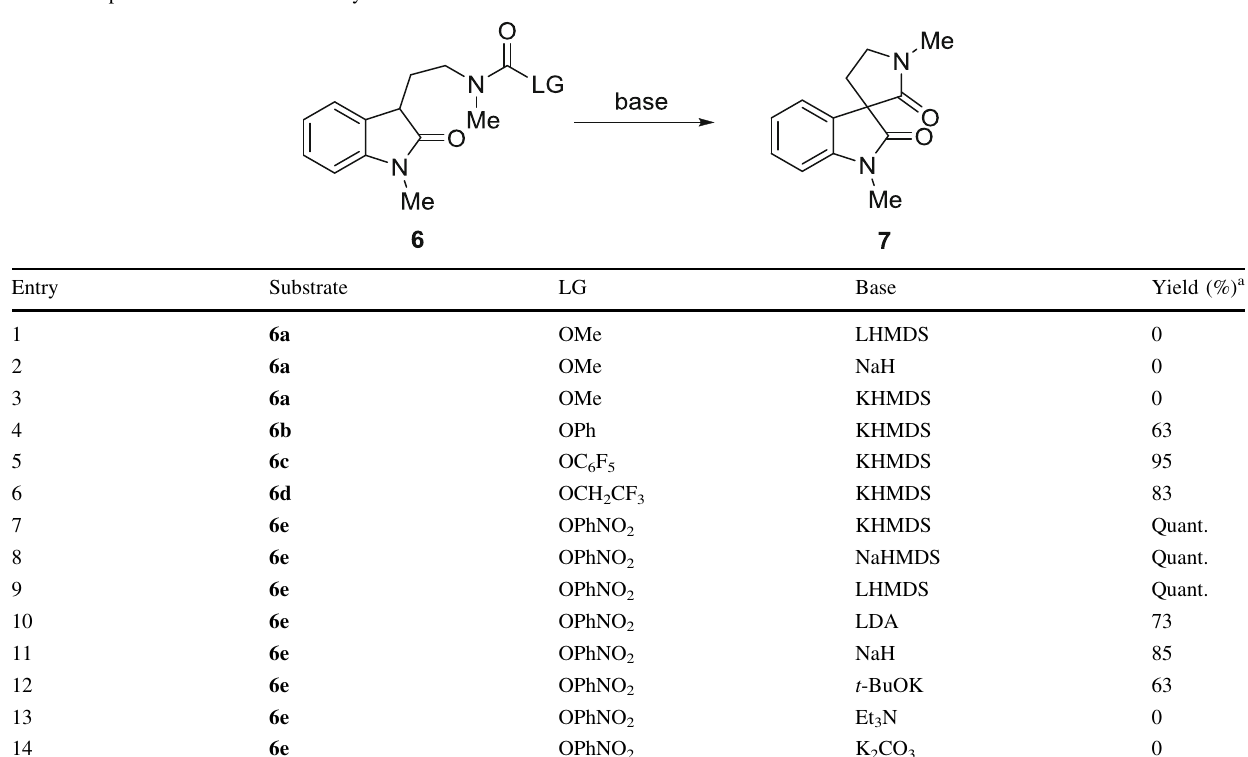
Table 1 Optimization of Dieckmann